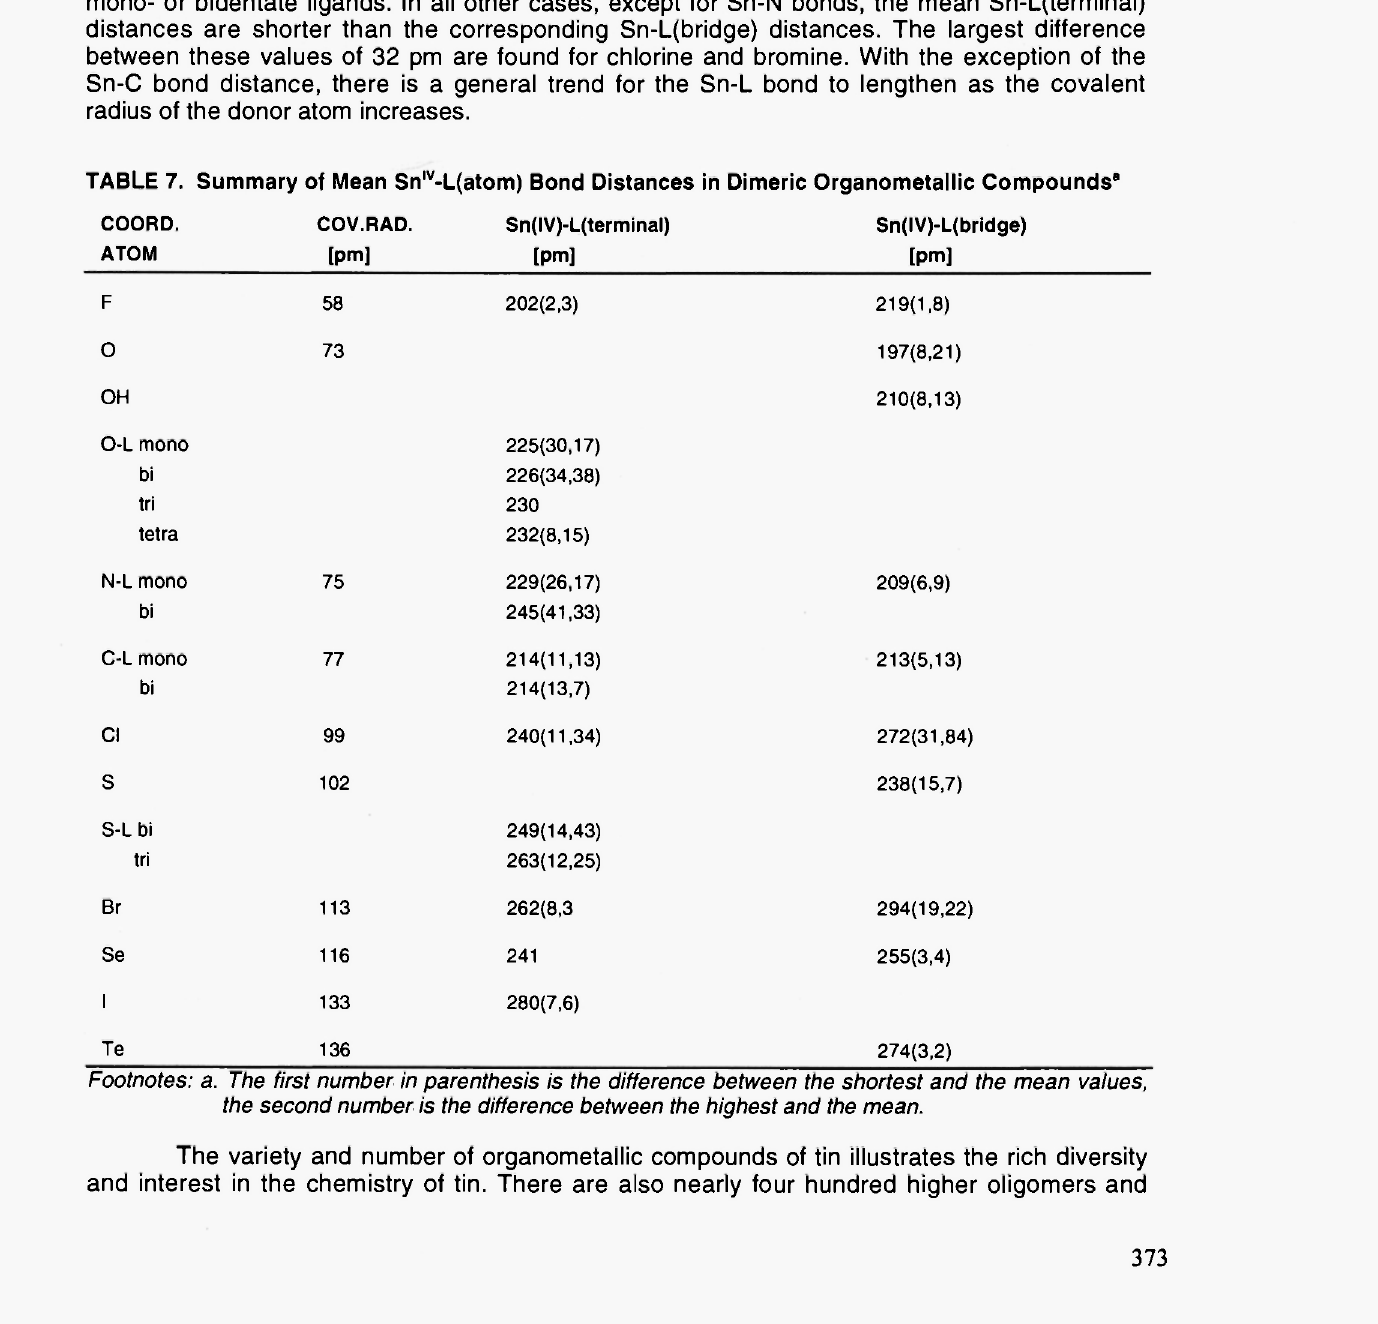
Footnotes: a. The first number in parenthesis is the difference between the shortest and the mean values, the second number is the difference between the highest and the